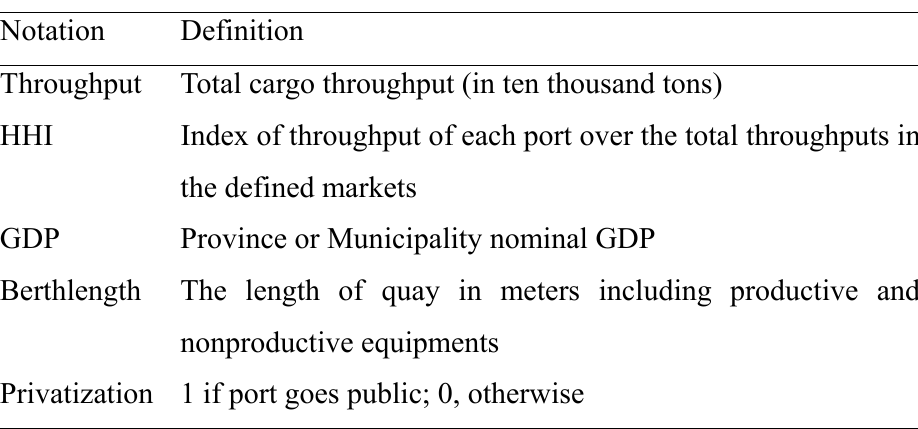
Table 2. Definition of Variables